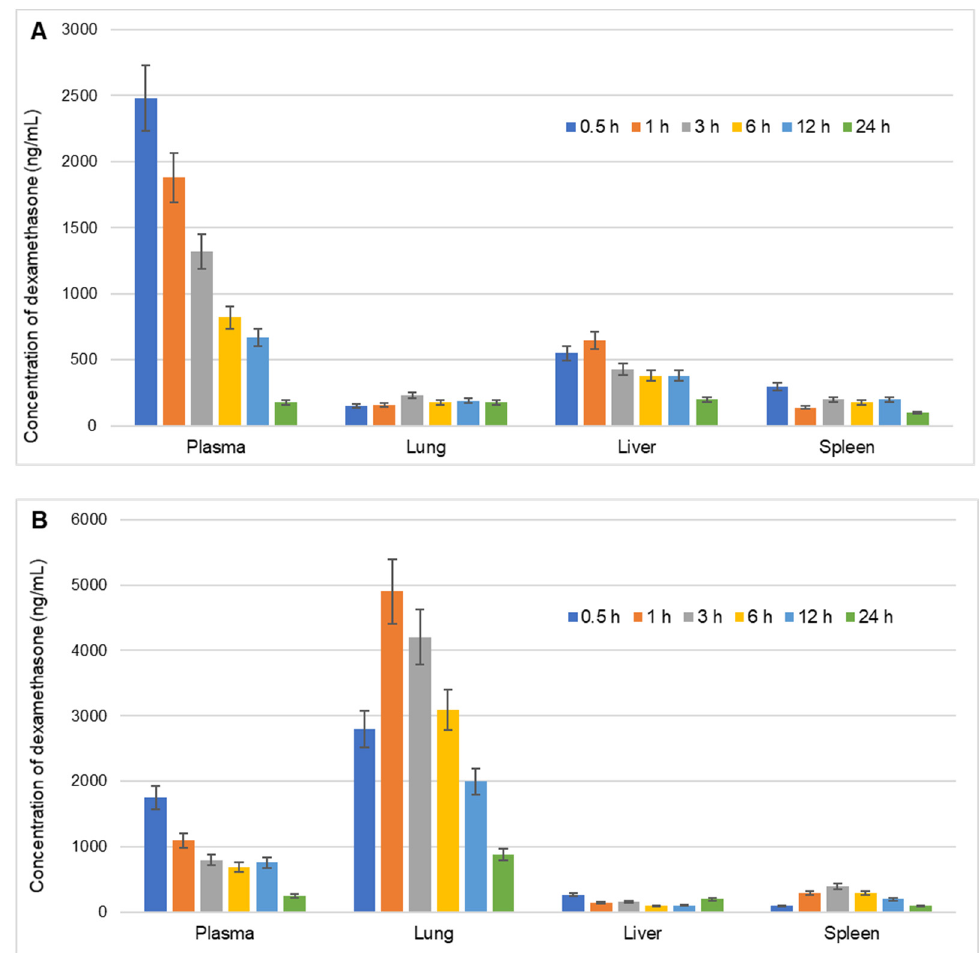
Figure 3. Biodistribution of dexamethasone in various organs namely, liver, lungs, and spleen (ng/g) and plasma (ng/mL) of rats at different time intervals over a period of 24 h after intravenous injection of ( A ) Conventional marketed injection of dexamethasone and ( B ) Dexamethasone-loaded lipopolymeric microspheres. Values are the mean of 3 determinations and error bars indicate standard deviation.